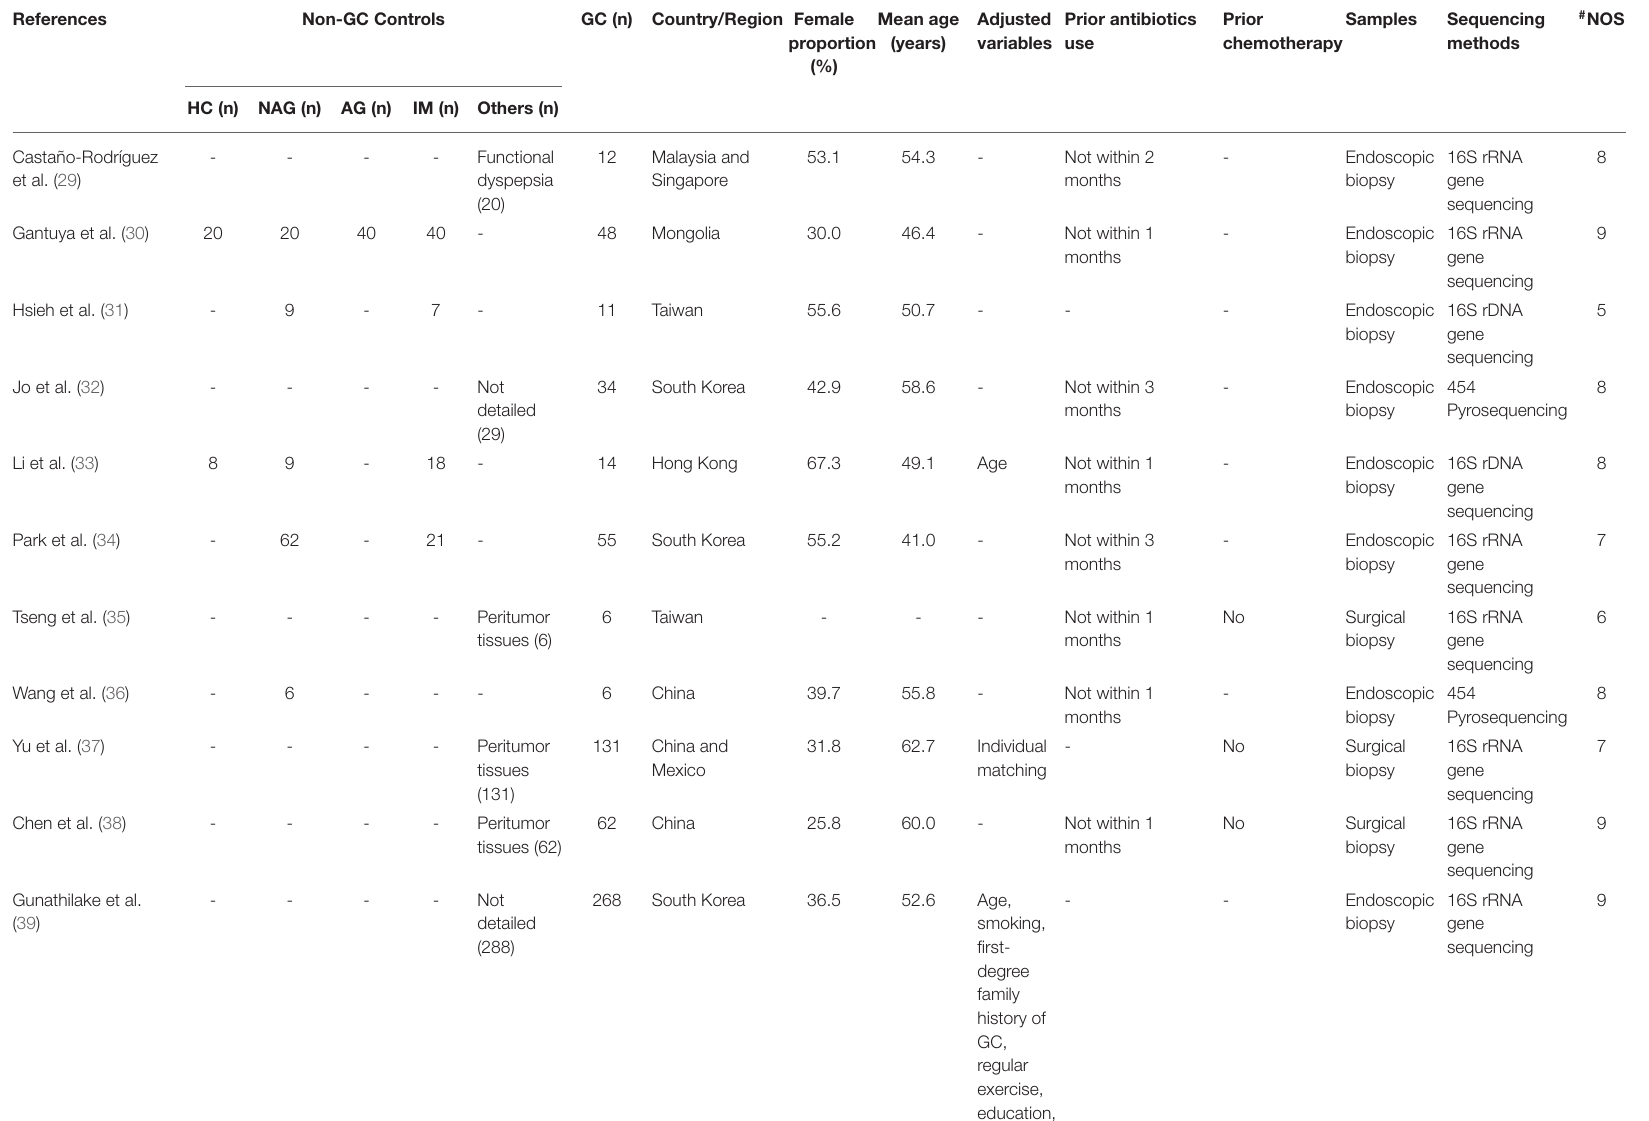
TABLE 1 | Basic characteristics of included